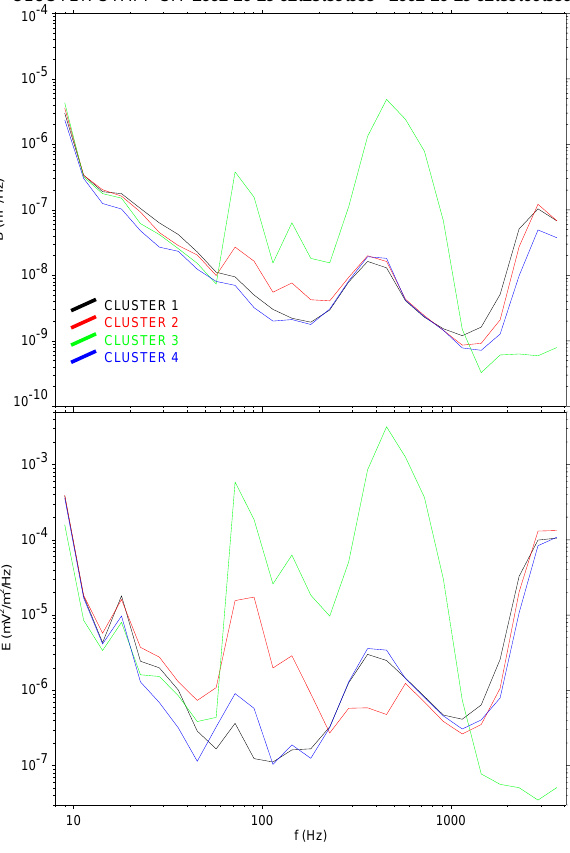
Fig. 4. Power spectral densities of the magnetic (top) and electric (bottom) components during the time interval 02:24–02:35UT. The curves are colour-coded according to each SC. The peaks at 70 and 140Hz are